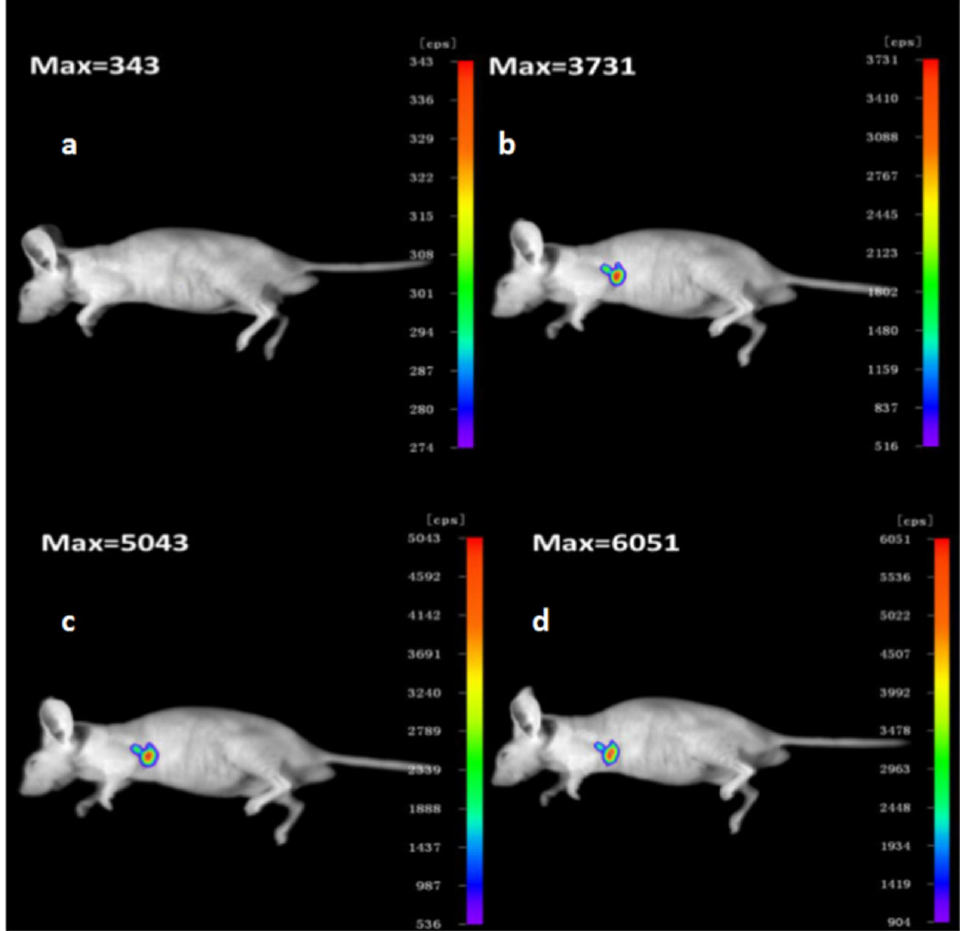
Figure 5. ( a ) mice were incubated with probe 56 (10 μ M) for 30 min; ( b ) mice were incubated with probe 56 (10 μ M) for 30 min and Na 2 SO 3 (50 μ M) 5 min; ( c ) mice were incubated with probe 56 (10 μ M) for 30 min and Na 2 SO 3 (50 μ M) 10min; ( d ) mice were incubated with probe 56 (10 μ M) for 30 min and Na 2 SO 3 (50 μ M) 25 min. Reproduced with permission from Ref. [90]. Copyright (2019) Elsevier.